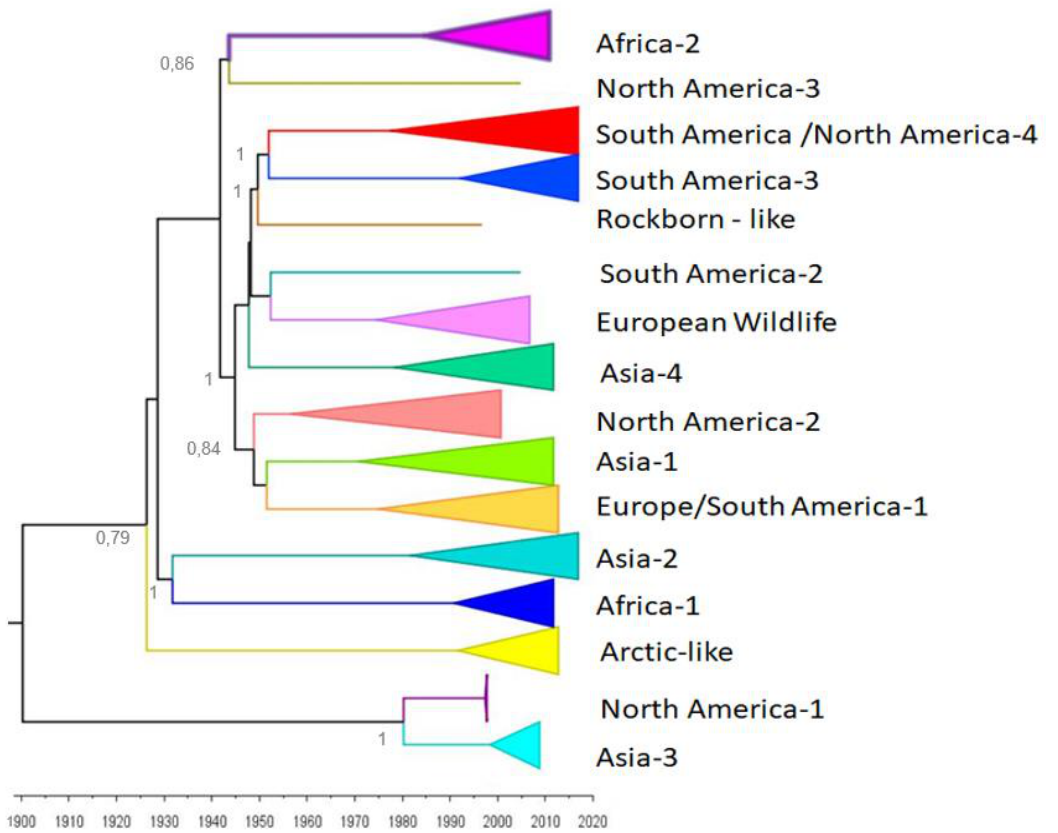
Figure 3. Time-measured Bayesian maximum clade credibility (MCC) tree for the CDV H gene using BEAST [140]. The time of the most recent common ancestor (tMRCA) of CDV is shown using 68 available sequences of the H gene for the lineages reported to date. Posterior probability limit: 0.7 are showed on